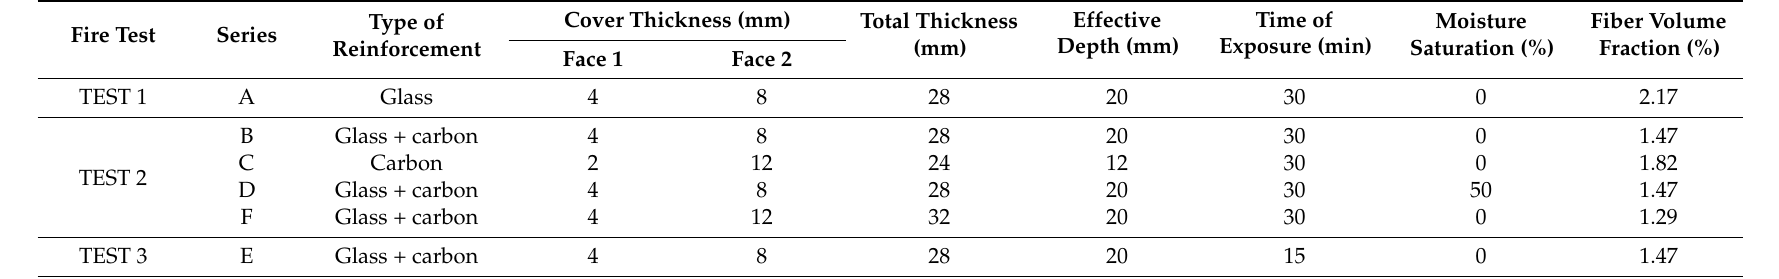
Table 2. Geometrical data and testing parameters for Series A to